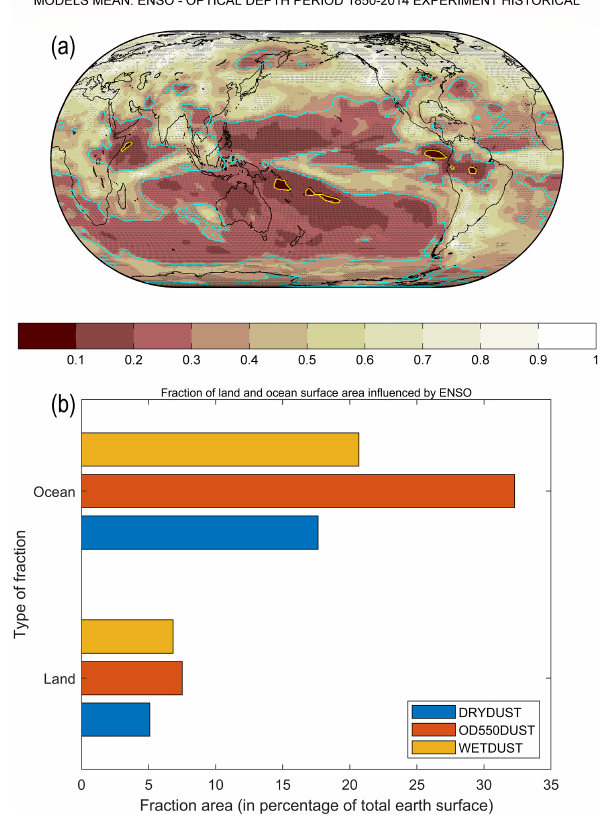
Figure 2. (a) As in Fig. 1, except for the probability for the absence of Granger causality from ENSO to annual mean dust aerosol opti- cal depth over the period 1850–2014 for the historical experiment. (b) Fraction of total Earth surface over land and ocean with proba- bility for no Granger causality from ENSO to dust deposition and dust aerosol optical depth smaller than 0.33 (i.e., p value < 0 . 33). Fraction areas affected by ENSO on dry dust, dust aerosol optical depth, and wet dust are displayed in blue, red, and yellow bars, re- spectively. ENSO: El Niño–Southern Oscillation.